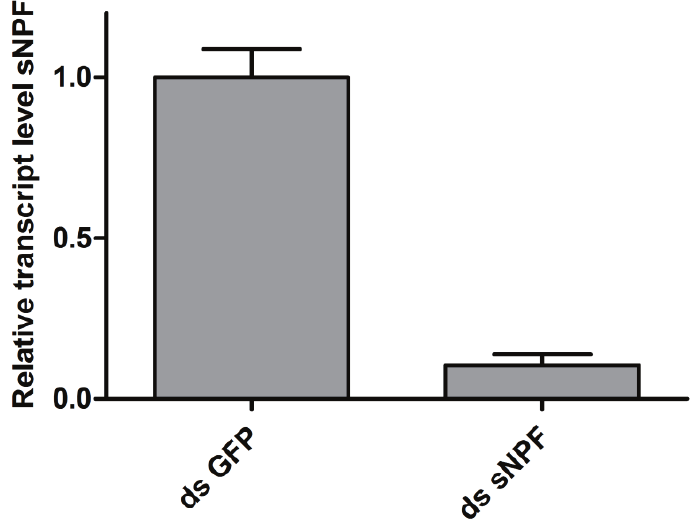
Figure 4. Relative Schgr -sNPF precursor transcript levels in the optic lobes of the brain upon Schgr -sNPF knockdown. Locusts were injected with 200 ng dsRNA corresponding to either GFP or sNPF. Injection of sNPF dsRNA resulted in an 89% reduction in transcript levels five days after injection. Data represent mean values ± SEM ( n =